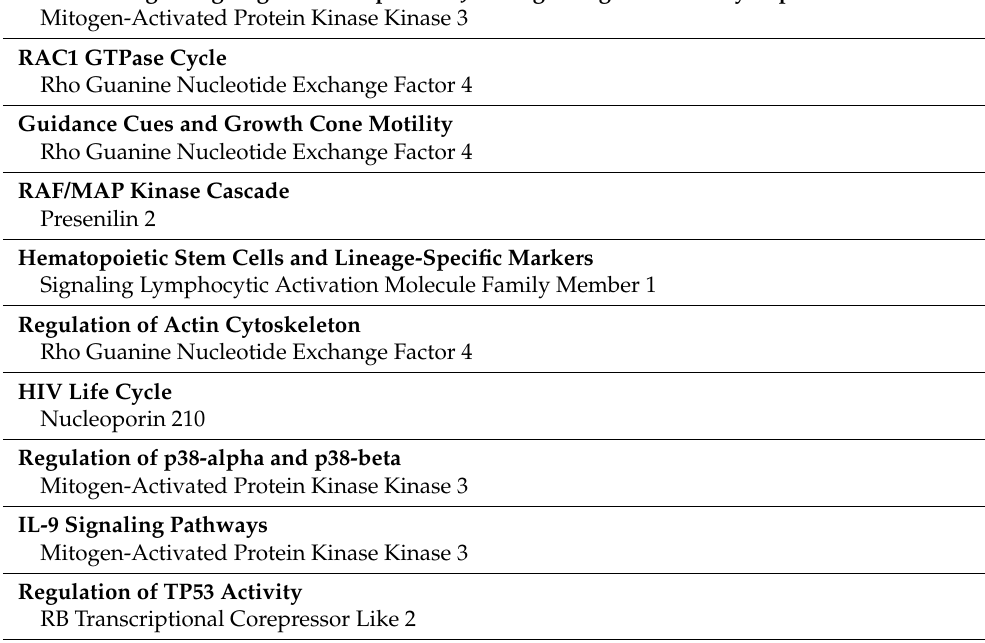
Table A2. Cont. G-Protein Signaling Regulation of p38 and JNK Signaling Mediated by